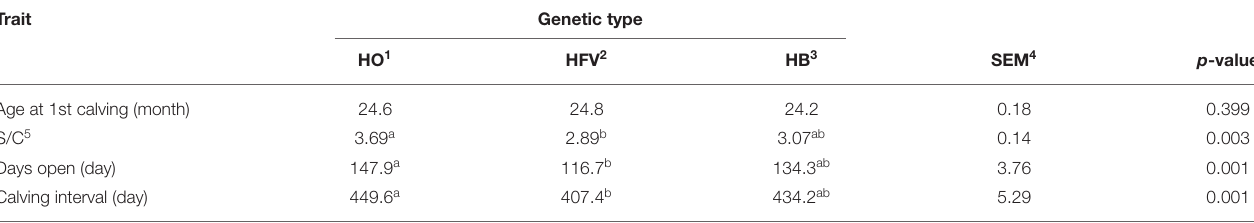
TABLE 1 | Age at first calving, service per conception rate, days open and calving interval of purebred Holstein, Holstein × Fleckvieh, and Holstein × Brown Swiss cows.